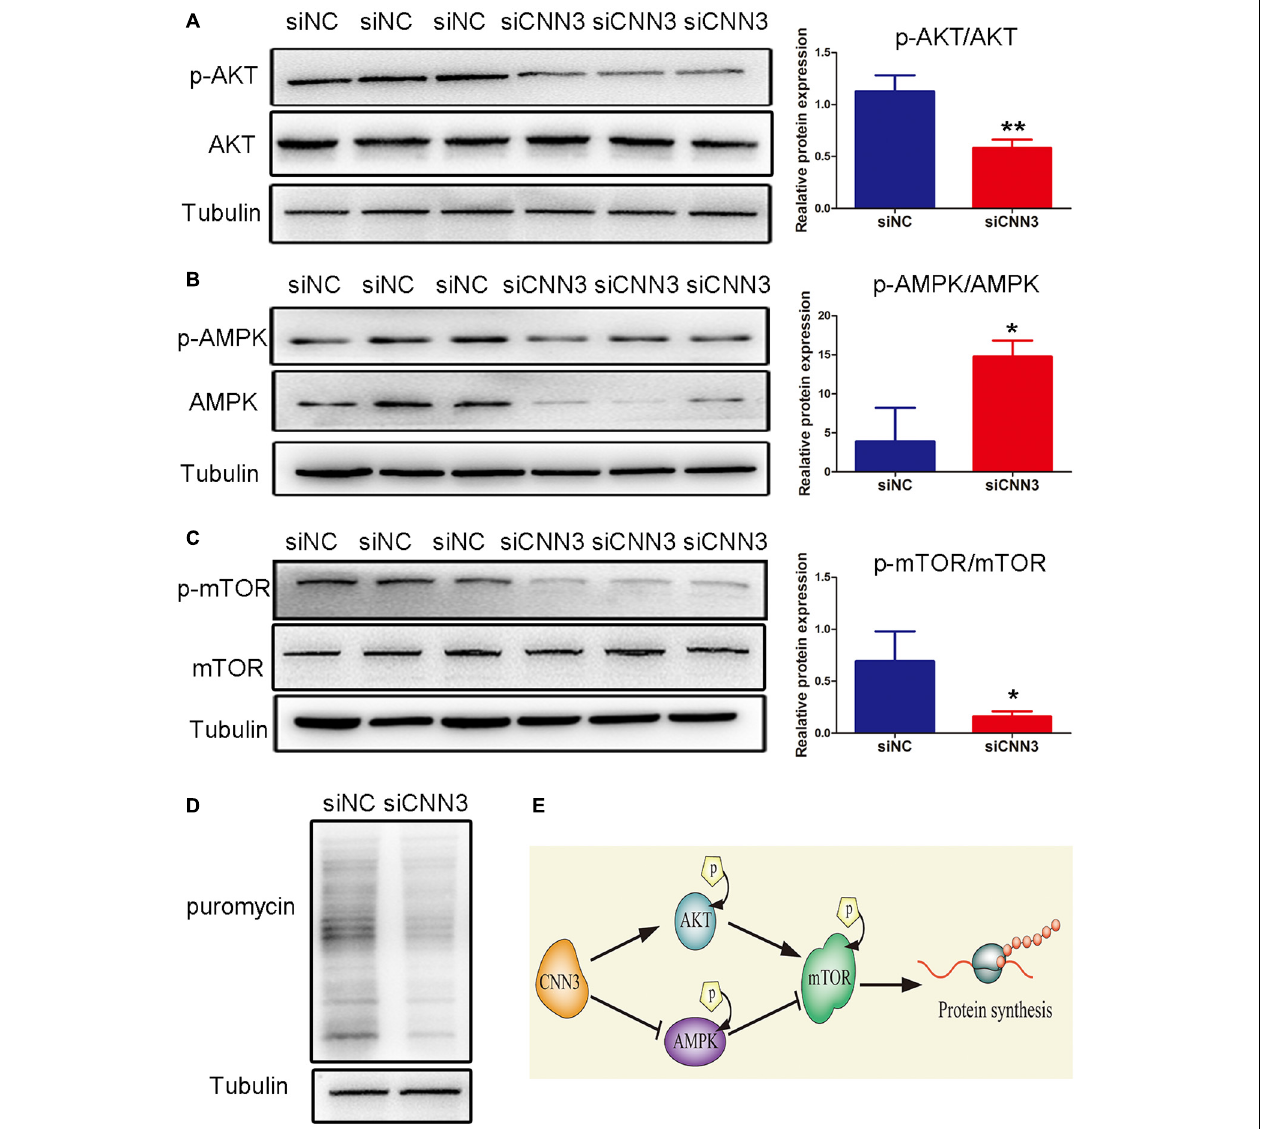
FIGURE 4 | CNN3 knockdown suppressed cell protein synthesis in C2C12 cells via the AKT/mTOR and AMPK/mTOR pathways. (A–C) Western blot analysis of the protein levels of (A) p-AKT and AKT, (B) p-AMPK and AMPK, and (C) p-mTOR and mTOR in the NC siRNA (siNC) and CNN3 knockdown (siCNN3) groups. The Western blot bands were quantified using Image J, and tubulin was used as the internal control. (D) Newly synthesized proteins detected by Western blot analysis using an anti-puromycin antibody in the siNC and siCNN3 groups. (E) A schematic representation of our proposed mechanism for the role of CNN3 in protein synthesis in C2C12 cells.* P < 0.05, ** P < 0.01 compared with the siNC